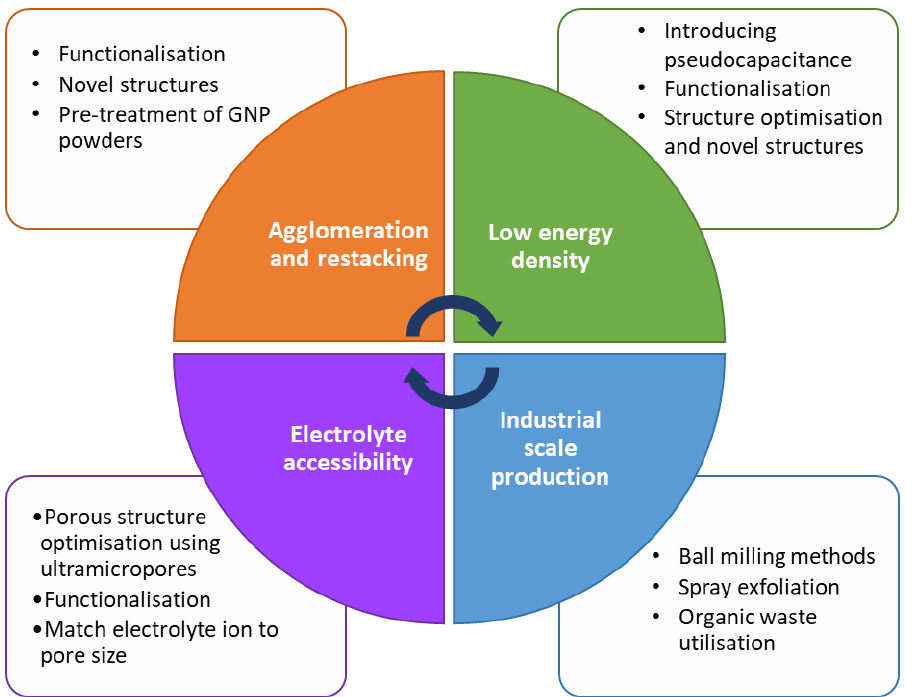
Figure 18. Summary diagram showing the main challenges facing GNP supercapacitors in the centre, and the possible solutions for each respective challenge around the